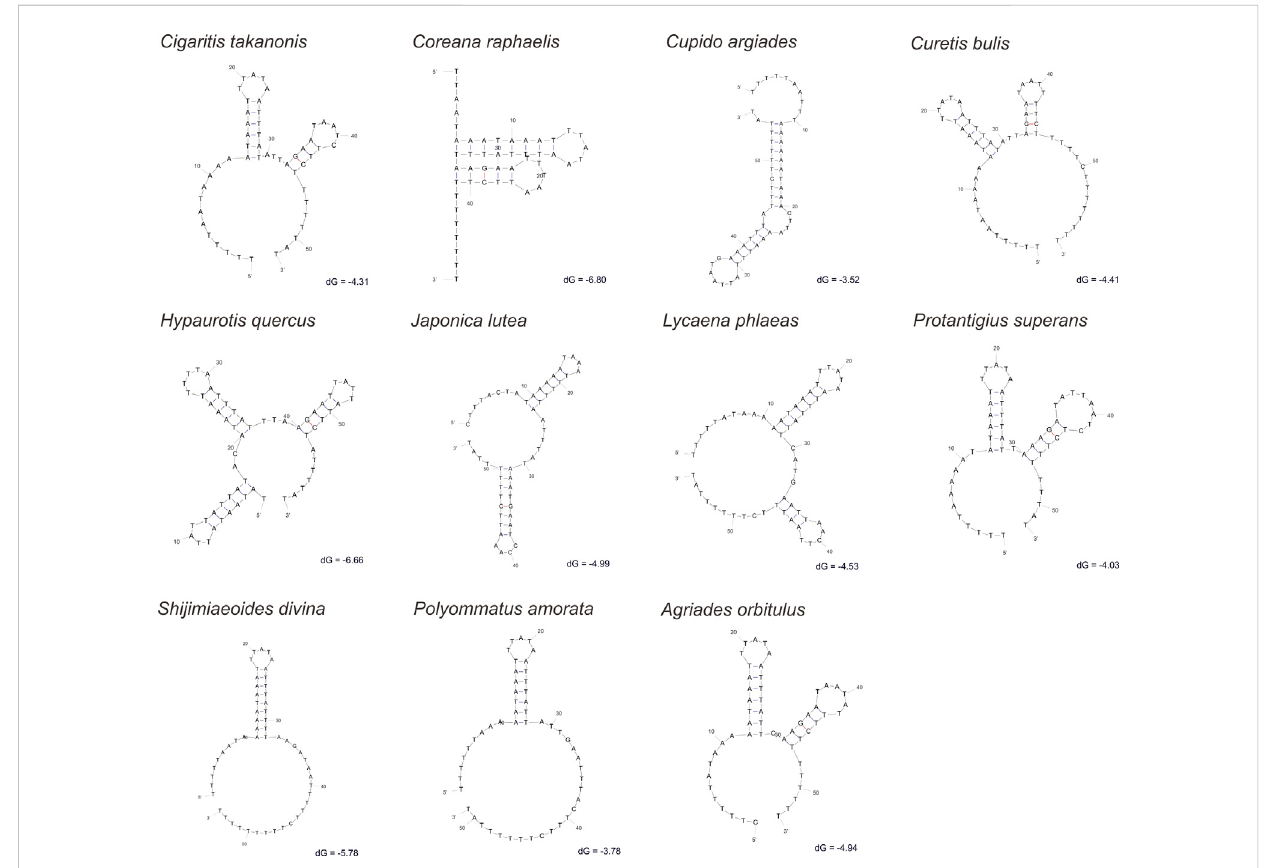
FIGURE 8 Non-coding region between trnQ and nad2 in Lycaenidae mitogenomes. dG, free energy, kcal/mol. The most stable structure was selected.